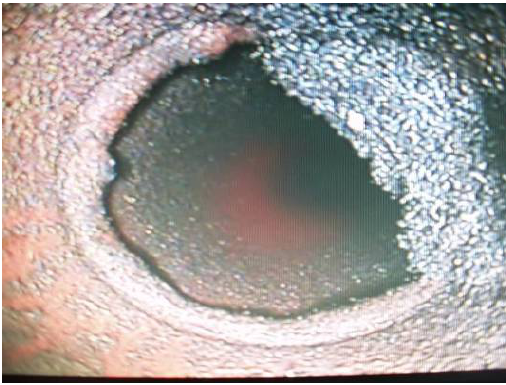
Figure 3: Photo of interior surfaces